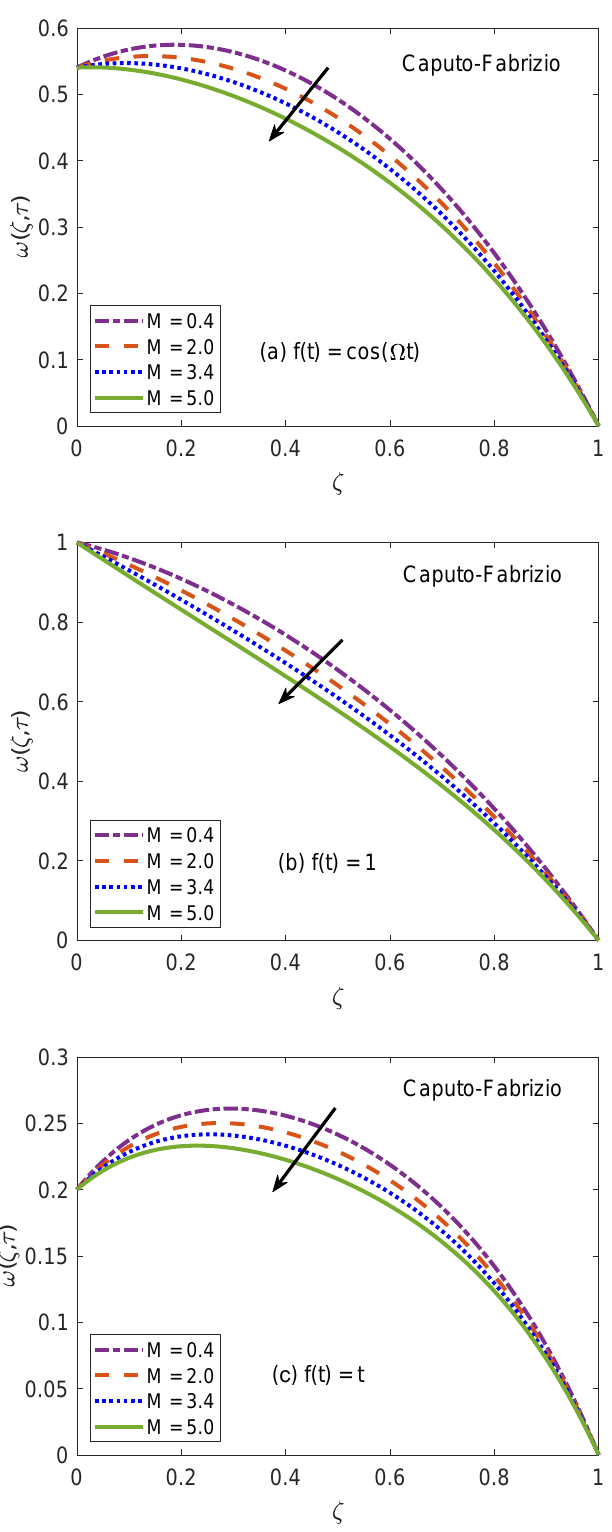
Figure 17. Velocity patterns of CF model for variation of M